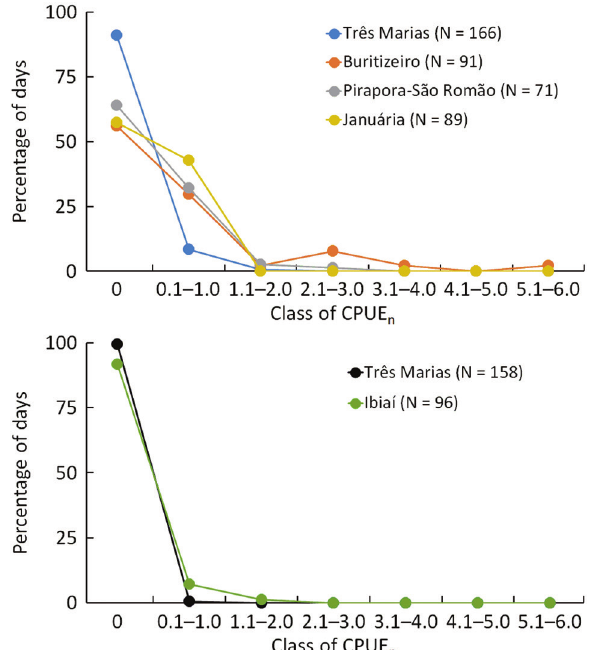
Fig. 3. Percentage of days with Conorhynchos conirostris captures per CPUE class by fishing site for artisanal n (top panel) and sport (bottom panel) fishing. (CPUE = 0 n corresponds to days with zero pirá captured; N = number of sampling days; the Pirapora-São Romão fishing site does not include data from